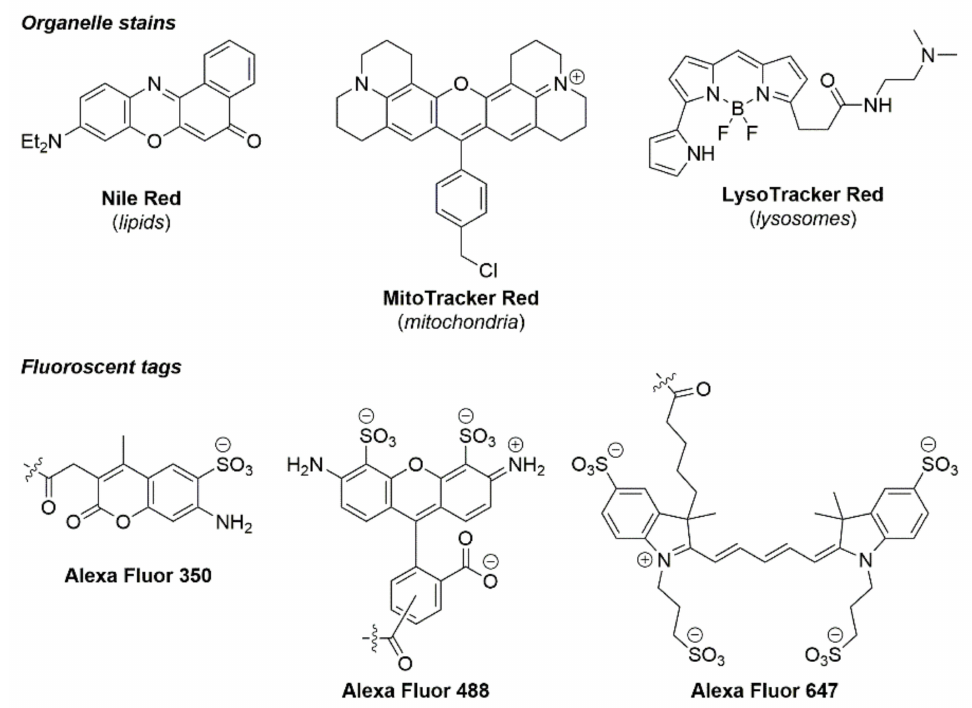
Figure 11. Commercially available fluorophores for organelle staining ( top , target organelle in parenthesis) and bioconjugation ( below